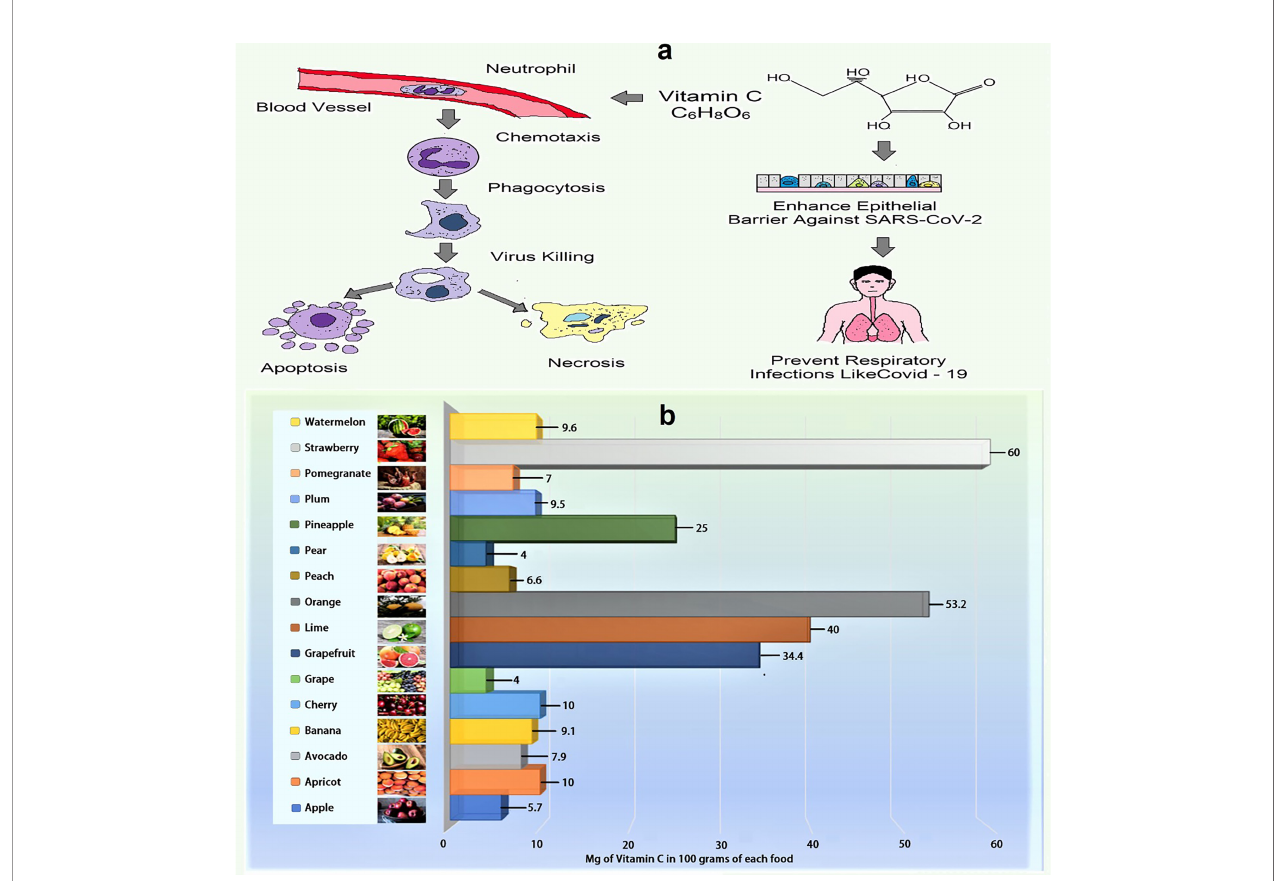
FIGURE 2 | (A) Role of vitamin C in phagocytosis (Vitamin C promotes neutrophil movement in response to chemoattractants and microbes engulfment, as well as formation of reactive oxygen species and microbial death. It also stimulates caspase-dependent apoptosis, boosting macrophage uptake and clearance, and suppresses necrosis, including NETosis, promoting in fl ammatory resolution and reducing tissue damage). (B) Amount of vitamin C in selected fruits (per 100 g) (124 –